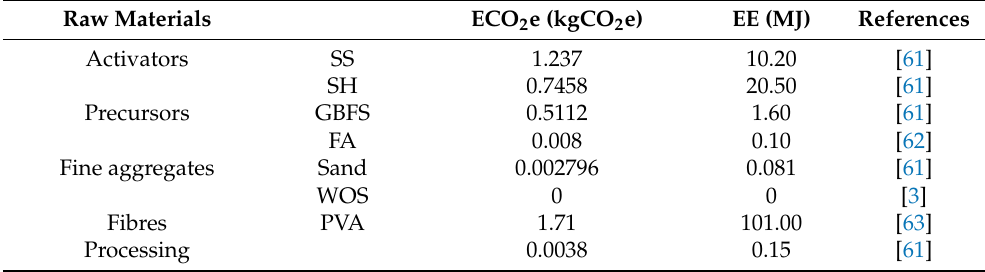
Table 4. ECO 2 e and EE of Raw Materials (per